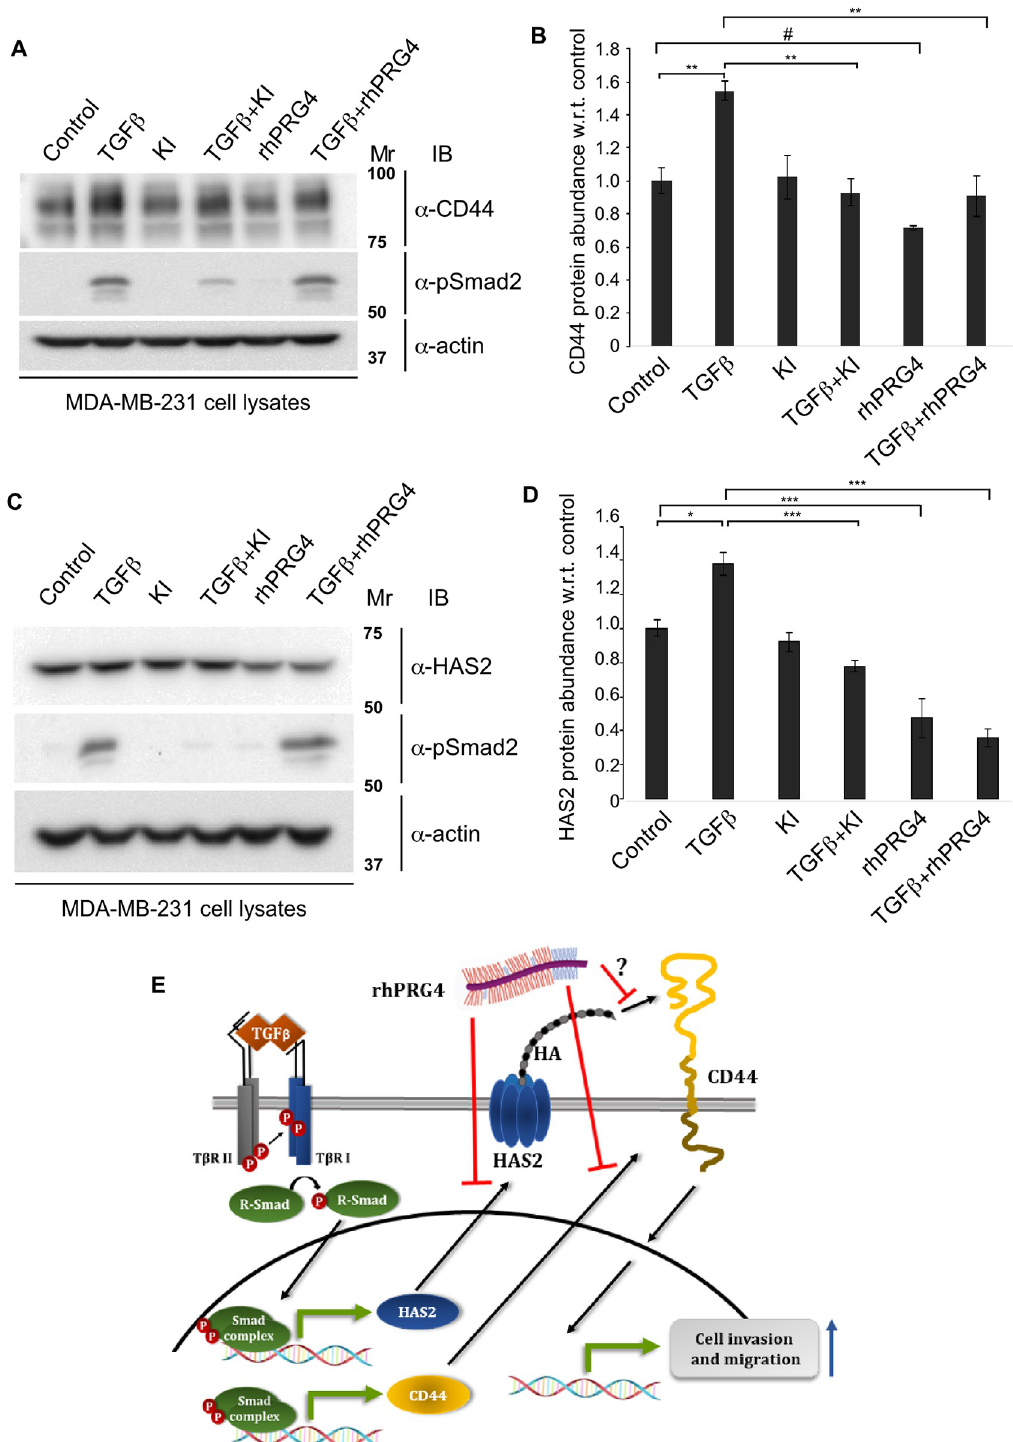
Fig 8. rhPRG4 and TGF β have opposing effects on the protein abundance of CD44 and HAS2. (A) CD44 and phospho- Smad2 (pSmad2) immunoblots of lysates of MDA-MB-231 cells incubated in complete growth medium without (control) or with 100 pM TGF β , alone or together with 10 μ M KI or 100 μ g/mL rhPRG4. Actin was used as loading control. (B) Bar graph depicts mean ± SEM proportion of CD44 immunoreactive band in each treatment condition from four independent experiments including the one shown in A. (C) HAS2 and phospho-Smad2 (pSmad2) immunoblots of lysates of